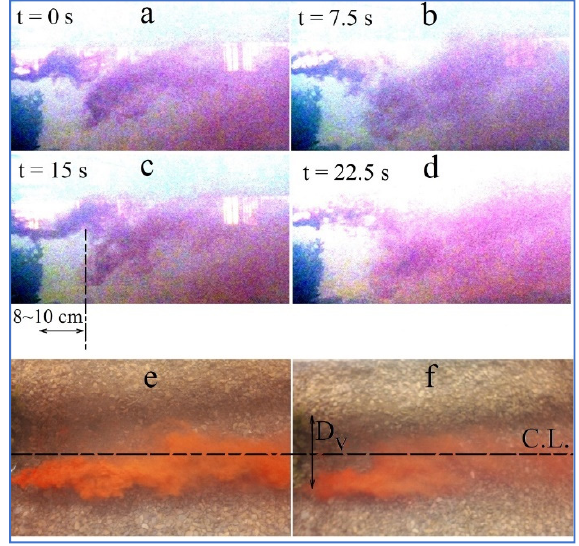
Figure 10. ( a – d ) Formation of the vertical vortexes and the wake zone behind the vegetation patch for case 4; ( e ) formation of the horizontal vortexes behind the patch with dike injection at z/Hv = 1 and ( f ) near the bed. Note that the injection point is located at the right edge of the patch for the horizontal vortexes.